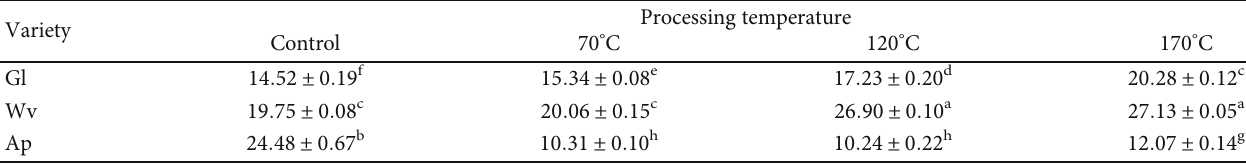
Table 2: Total phenolic content of thermally treated leafy vegetables (DW).